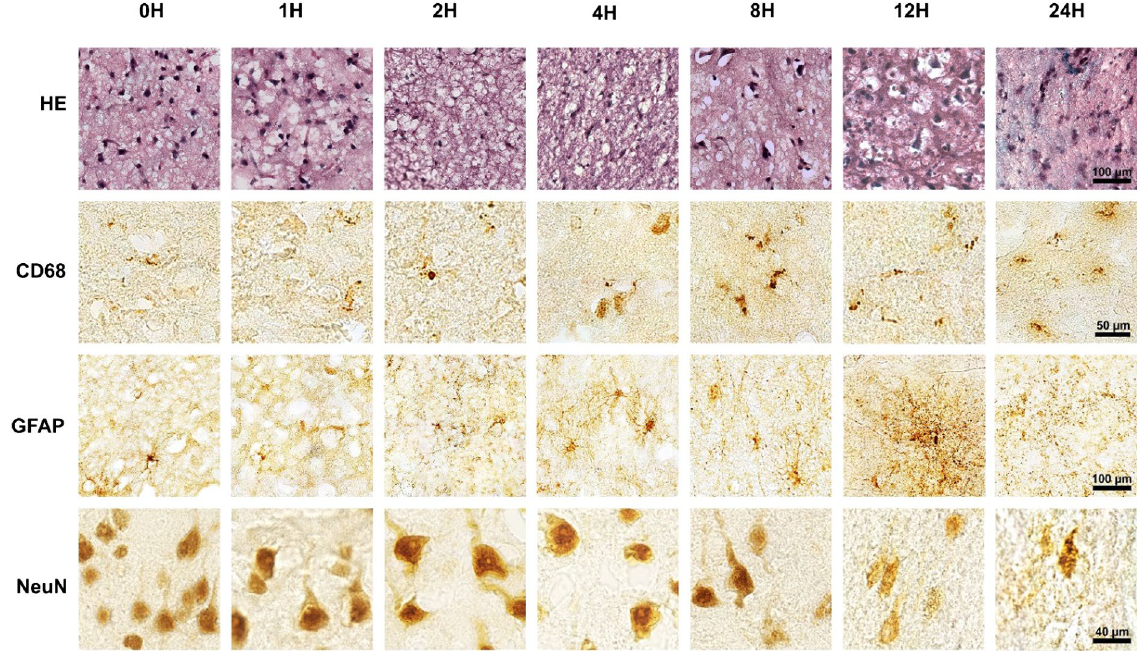
Figure 4. Loss of neuronal staining progressed while micro- and astro-glial processes greatly expanded during the simulated PMI. From 0 to 2H, glia in the gray matter were mainly non-reactive and neurons (NeuN) were degrading, starting at 4H and peaking at 12H the activation of microglia (CD68) and astrocytes (GFAP) was seen with overlapping cellular processes. Small GFAP positive nodules appeared on astrocytic processes at 8H and increased so that by 12H they became the most prominent form of GFAP staining. At 24H, tissues appeared physically degraded with astrocyte cell bodies no longer identifiable, neurons (NeuN) mostly degraded, and rounded microglia. (HE = hematoxylin & eosin